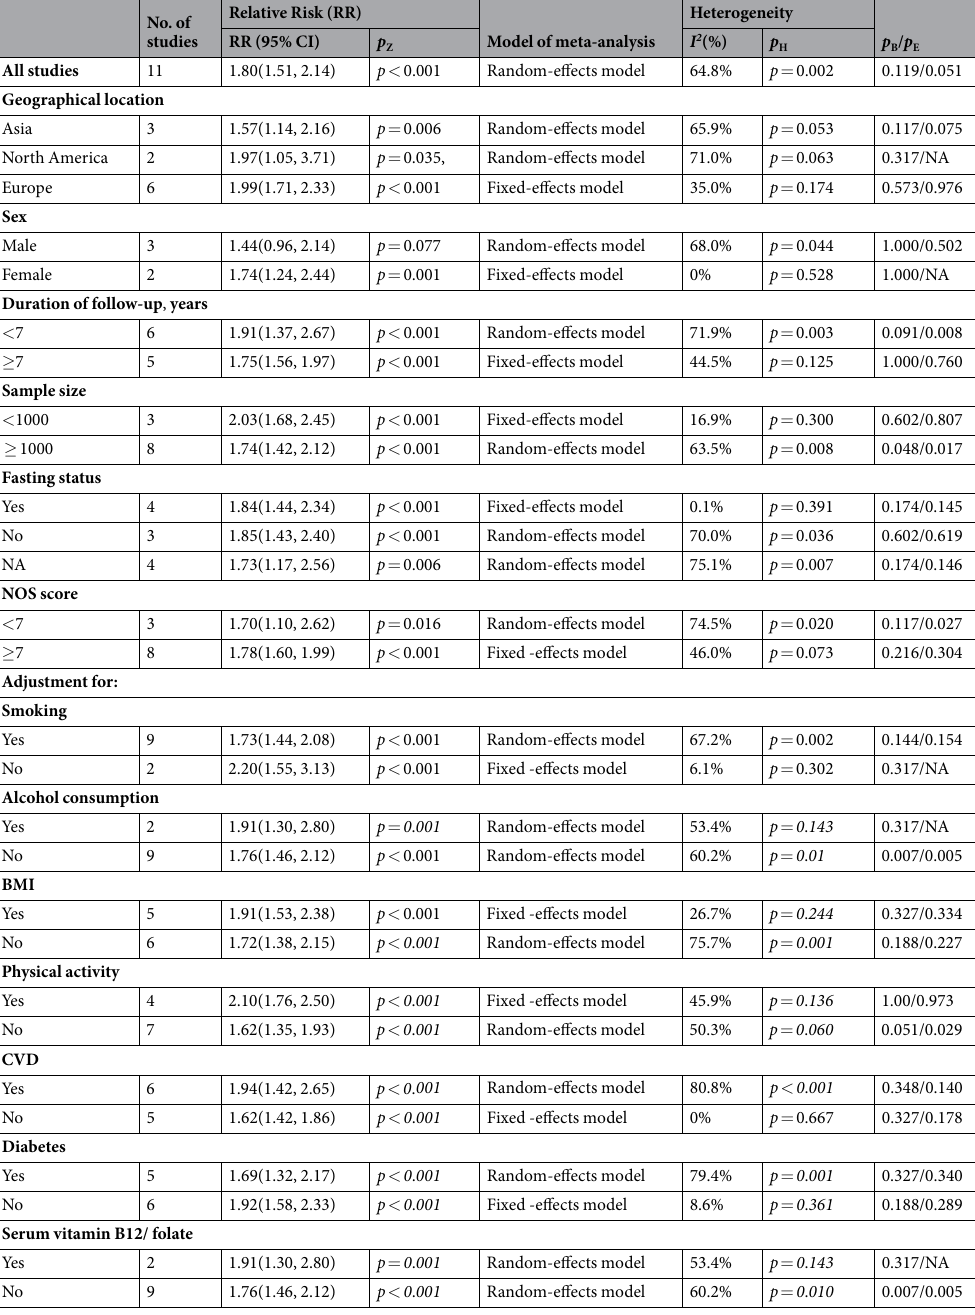
Table 2. The total and subgroup analyses for the relationship between Hcy levels and all-cause mortality risk. p z : p value of effect test; p H : p value of heterogeneity test; p B : p value of Bgger’s test; p E : p value of Egger’s test. NA: Not